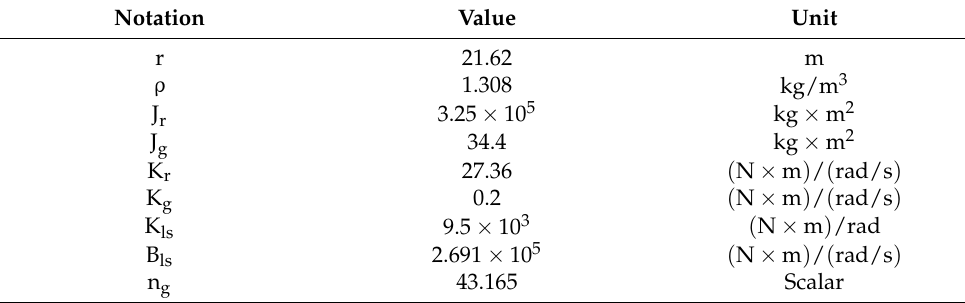
Table 2. The mechanical drivetrain parameters of VWTs.